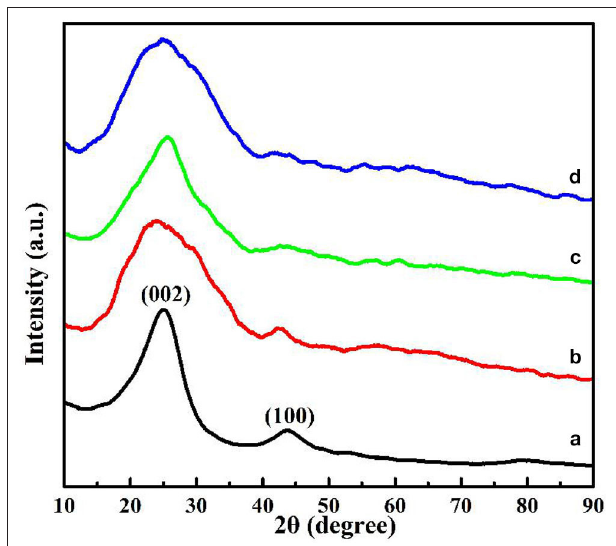
FIGURE 2 | X-ray diffraction patterns of the HNCMs synthesized with different amount of PAA: HNCMs-S (pattern a), HNCMs-N (pattern b), HNCMs-D (pattern c), and HNCMs-P (pattern